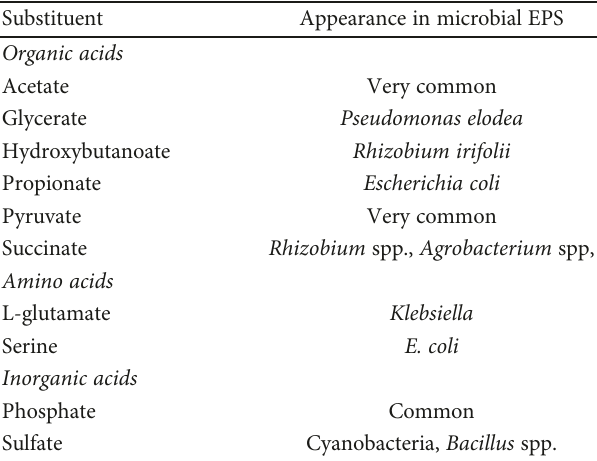
Table 2: Di ff erent noncarbohydrate substituents found in microbial